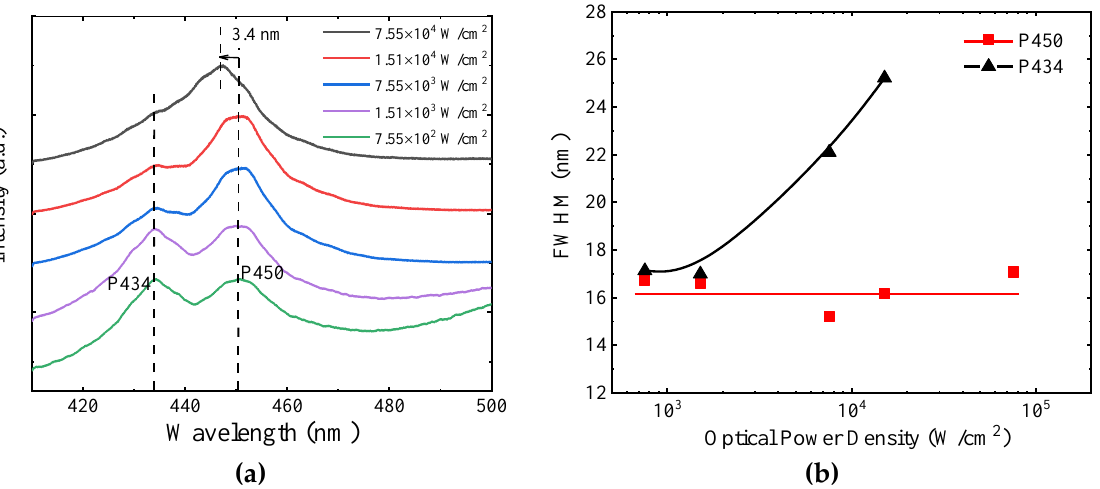
Figure 2. ( a ) The PL spectrum of the triangular-like ridge under different excitation power and ( b ) the FWHM curve of P434 and P450.